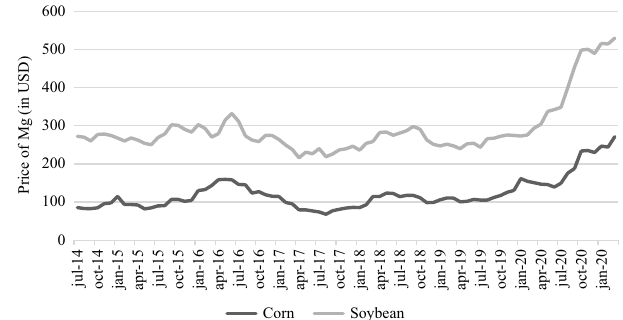
Figure 4. Evolution of corn and soybean prices from July 2014 to March 2020. Data were obtained from the Department of Rural Economy of the Paraná State Secretariat of Agriculture and Supply (DERAL-SEAB). The monetary values are corrected for inflation according to the Brazilian Extended National Consumer Price Index (IPCA) to December 2021.